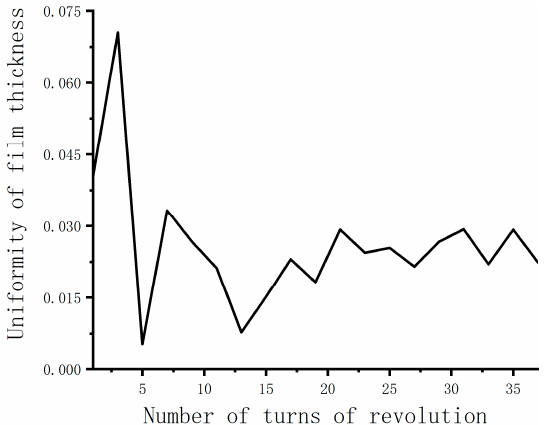
Figure 10. Film thickness uniformity versus the number of revolutions in the counter PRS for K = 217/37, n = 2, R = 620 mm, ρ ranging from 0–350 mm and source coordinates of ( − 900, − 300, 0).